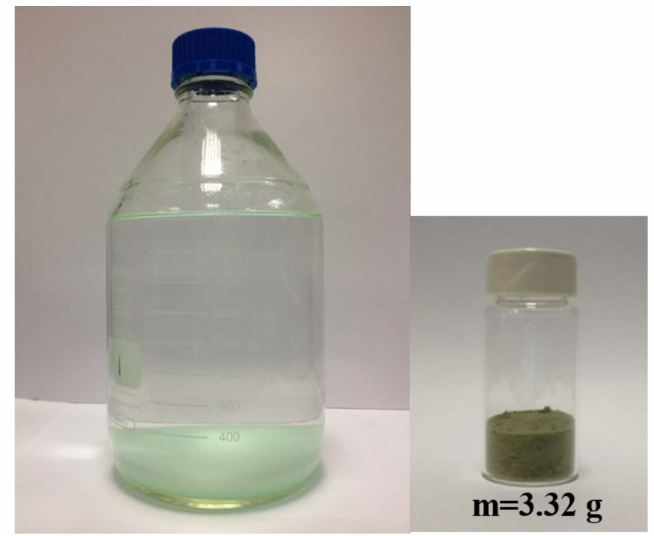
Figure 4. The optical graphs of a 2-L reaction and the as-obtained Ni 0.1 Mg 0.9 O nanoplates. 143